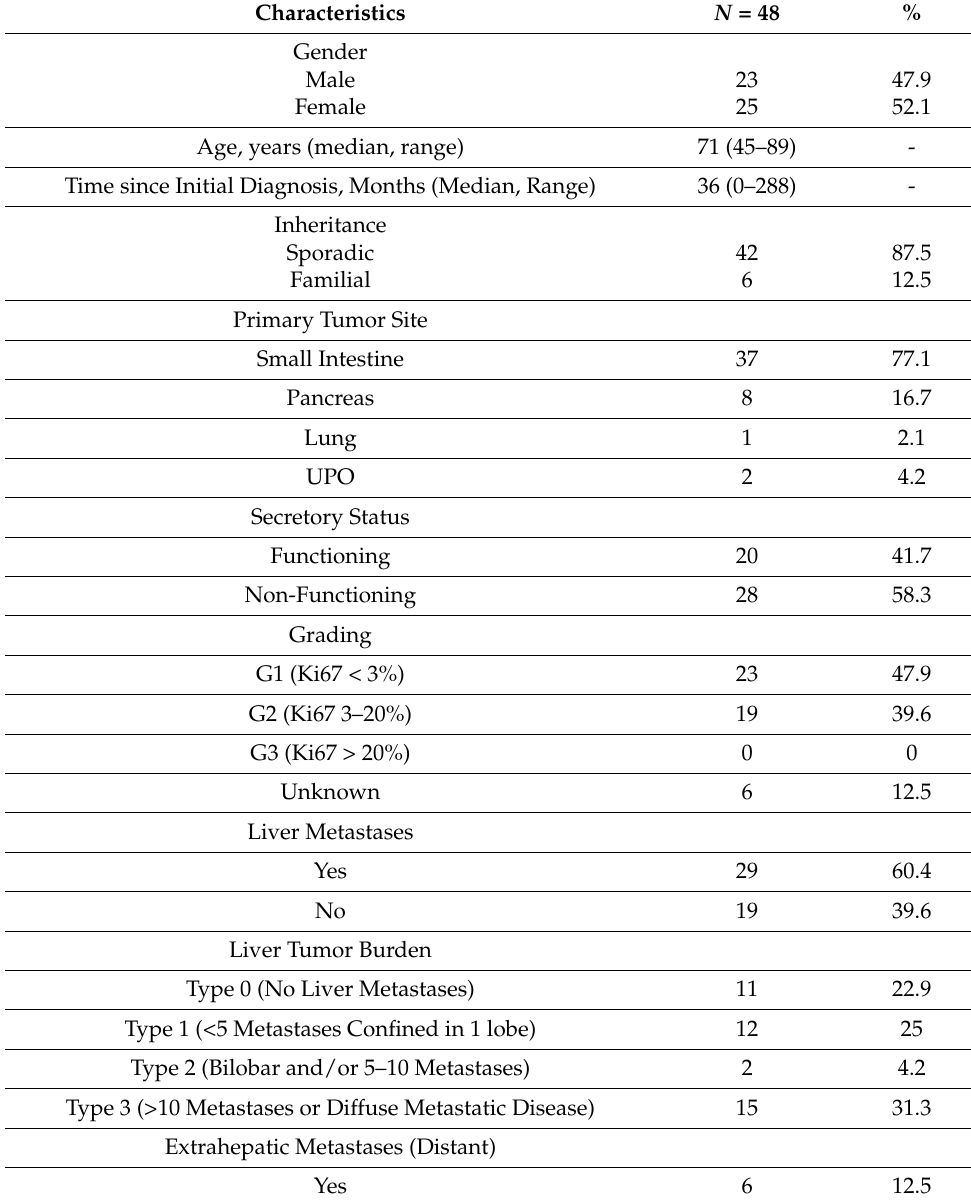
Table 1. Baseline patient and tumor characteristics of the study